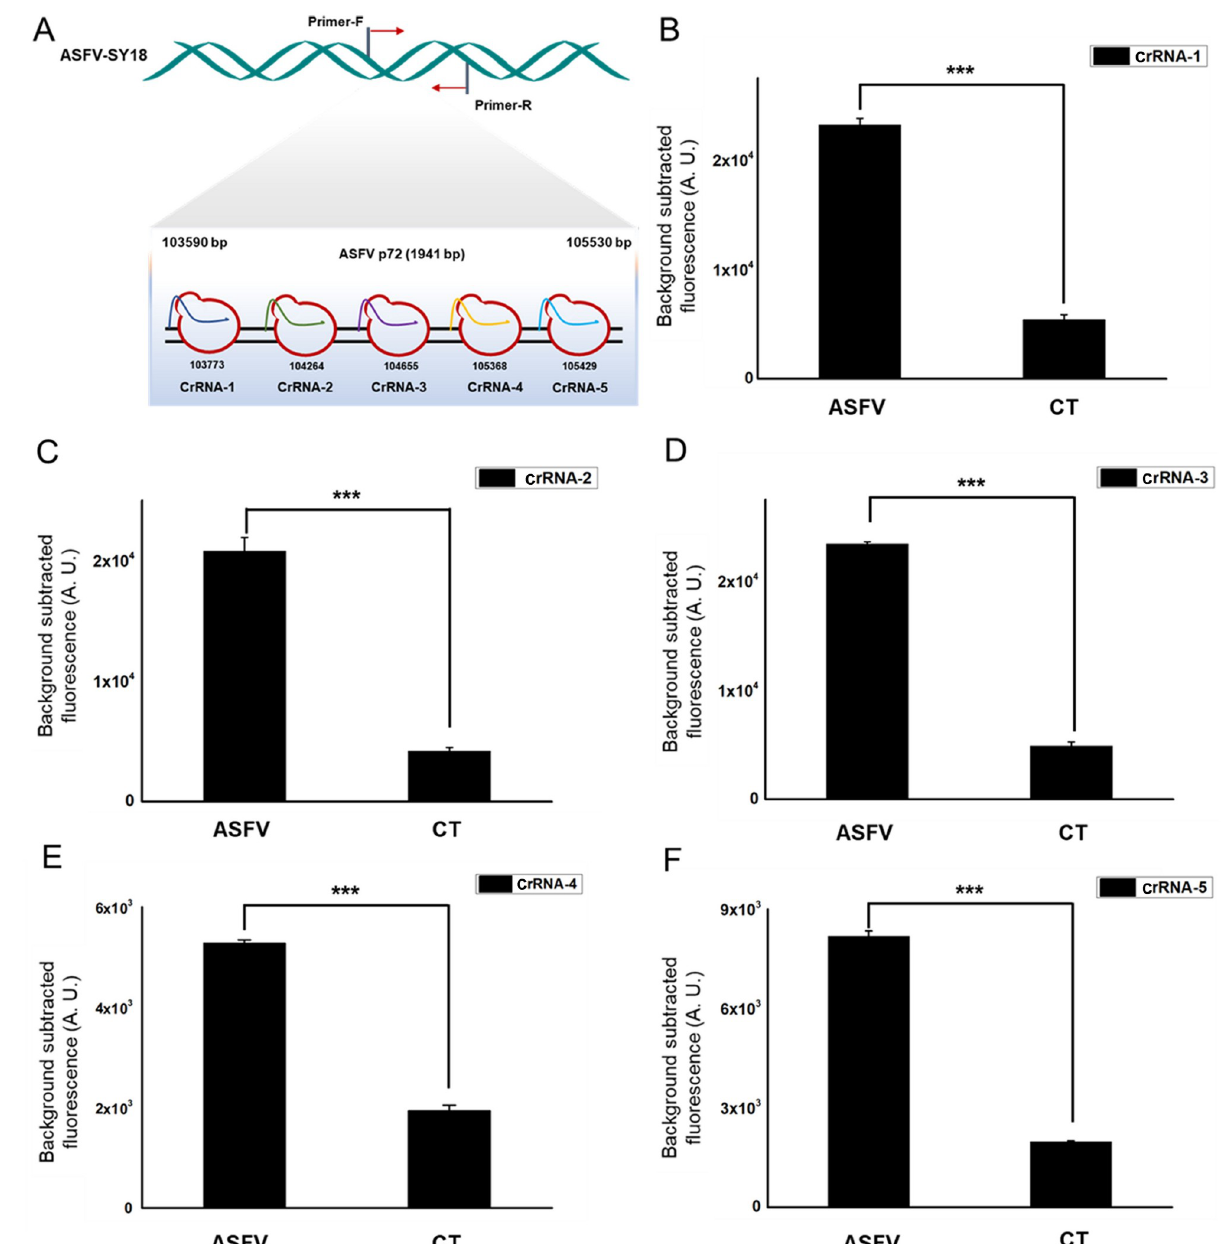
Fig 2. Screening for highly active crRNAs. (A). Schematic of the p72 gene, and the corresponding locations of each crRNA PAM region. (B-F). Fluorescence signals detected by five crRNAs targeting the ASFV p72 gene designed for the detection of ASFV. Background fluorescence by the individual crRNA in the absence of target DNA was shown as “CT”. n = three technical replicates, bars represent mean ± SD, ��� p < 0.001.